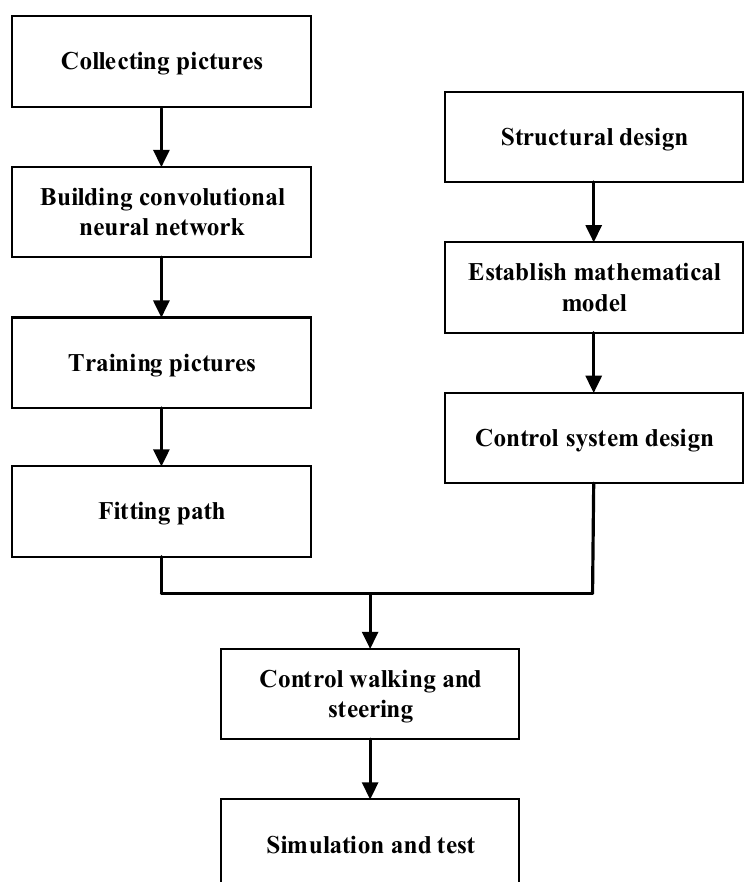
Figure 2. Flow chart of robot field path recognition.